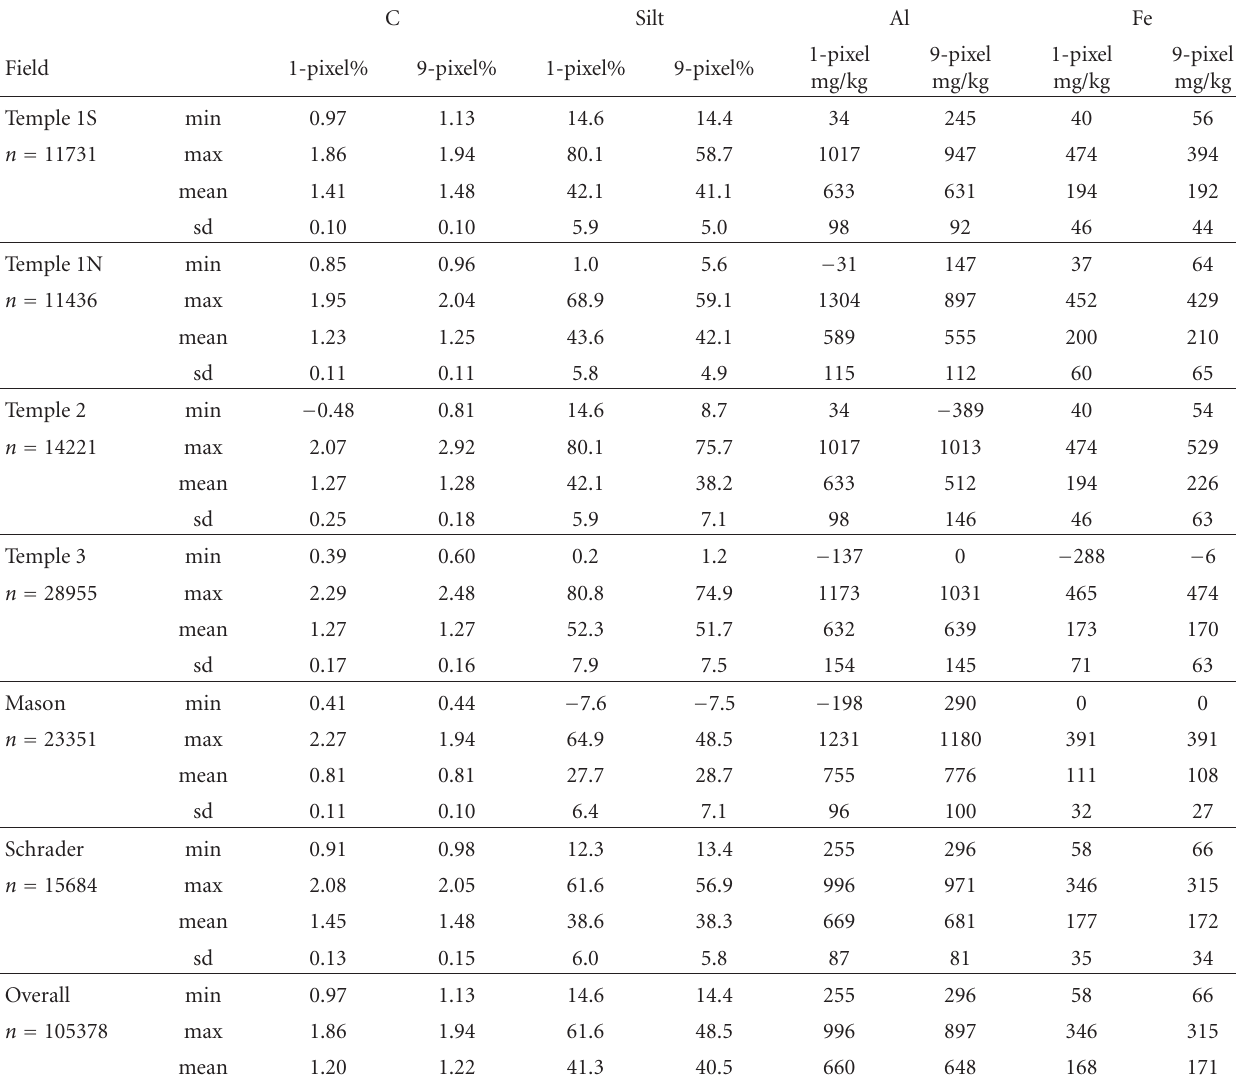
1 See Table 3 for the accuracy ( R 2 ) associated with each analyte prediction model.